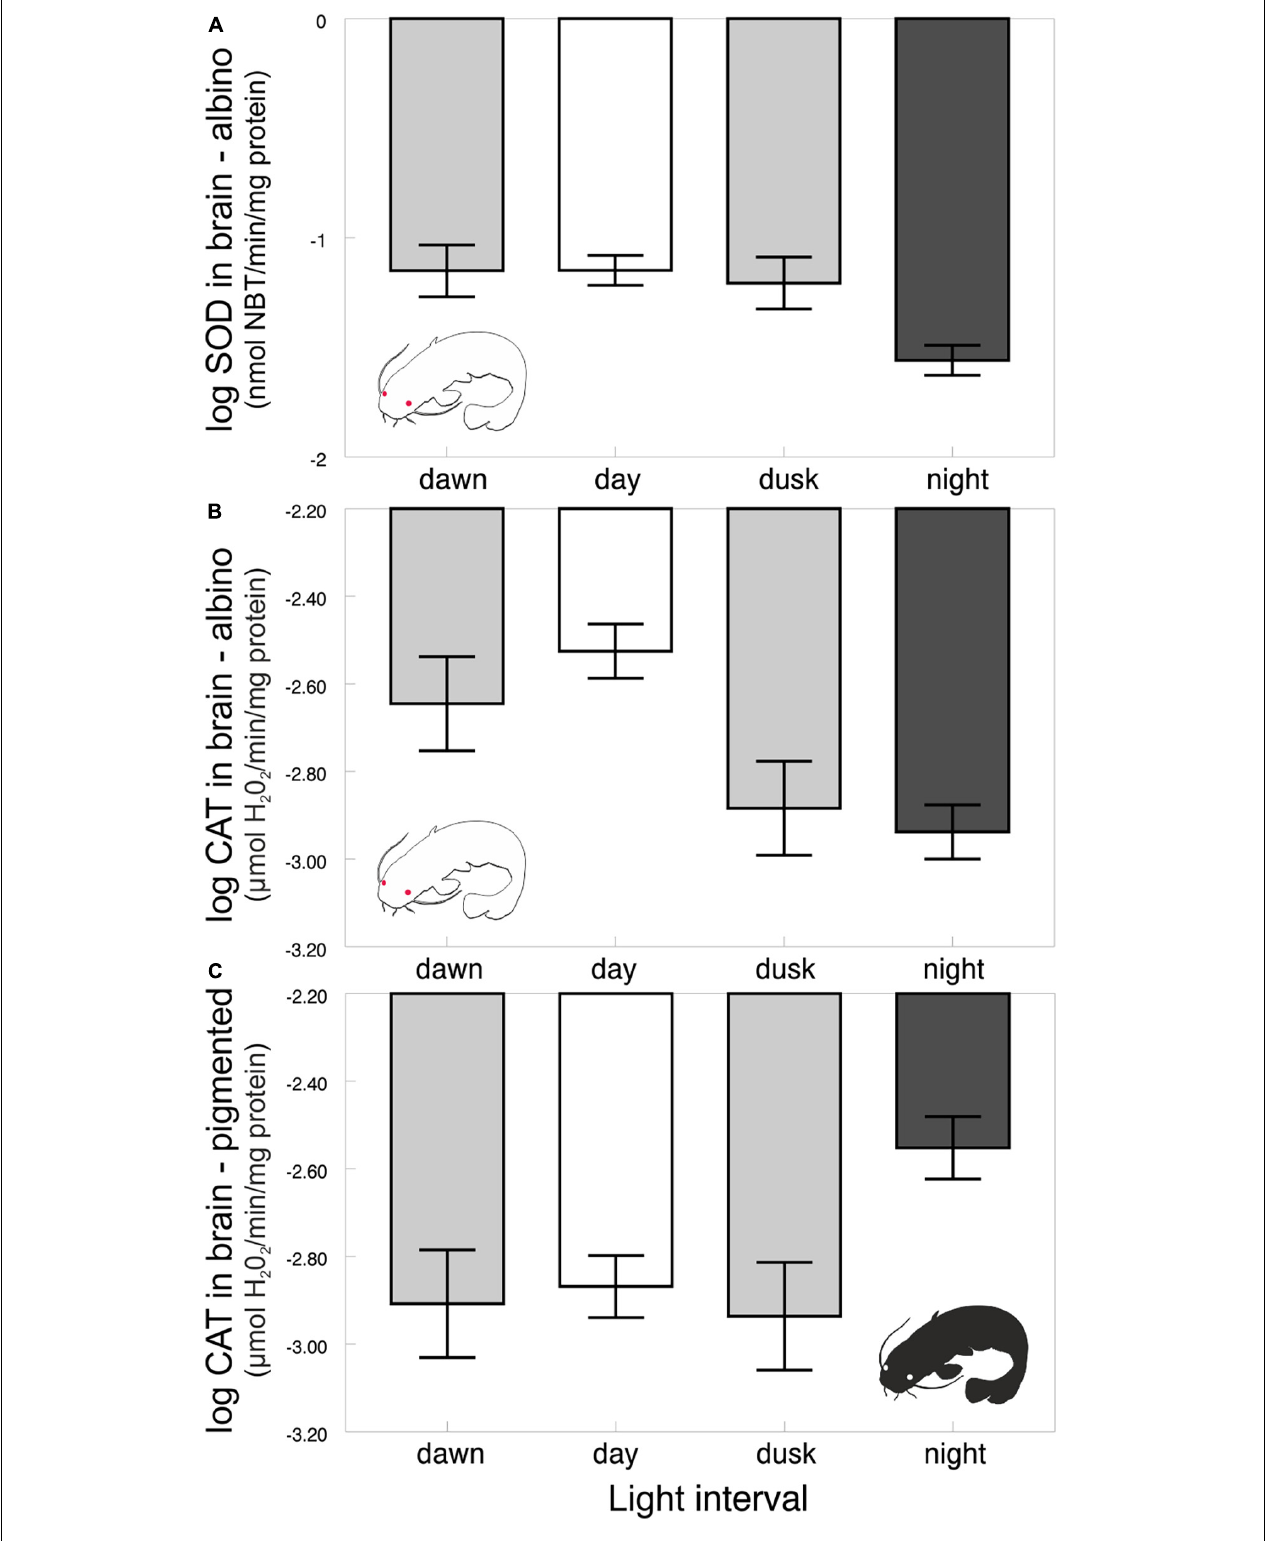
FIGURE 5 | Levels of antioxidants in brain of albino (SOD – A ; CAT – B ) and pigmented (CAT – C ) catfish across light intervals. Values ( ± SEs) of biochemical indices are predicted from the mixed models (i.e., presented data are after the adjustment by the statistical model).